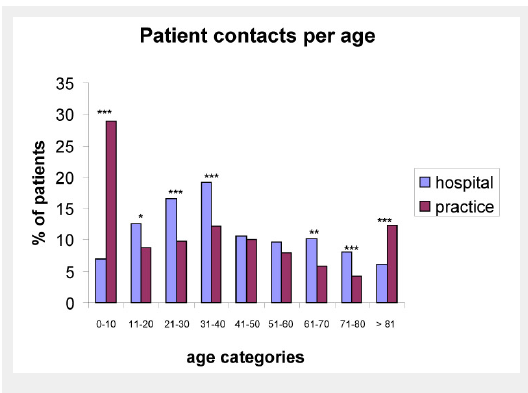
Distribution of patients according to age, seen at the emergency ward and by general practitioner, respectively. Differences marked are statistically significant: *p <0.05, **p <0.01, ***p